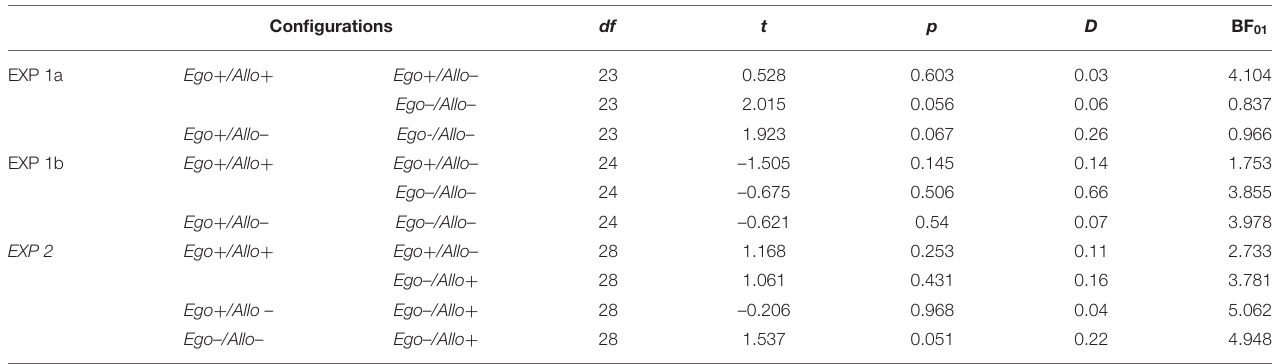
TABLE 2 | Reaction times comparisons (two-tailed paired samples T -test and Bayesian paired samples T -test) between configurations in the test phases of Experiment 1a, Experiment 1b, and Experiment 2. Configurations